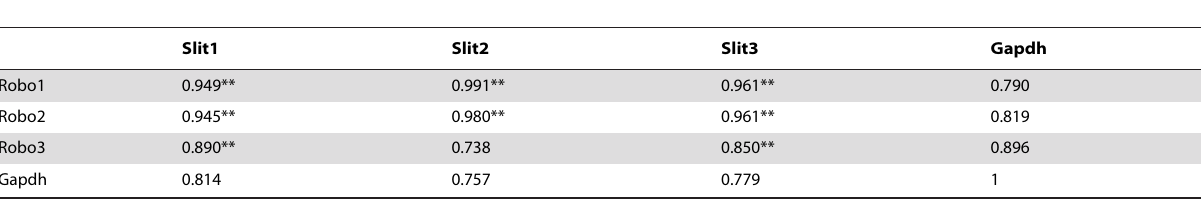
**the correlation value of Slit-Robo pair is significantly different from controls at 0.01 level.